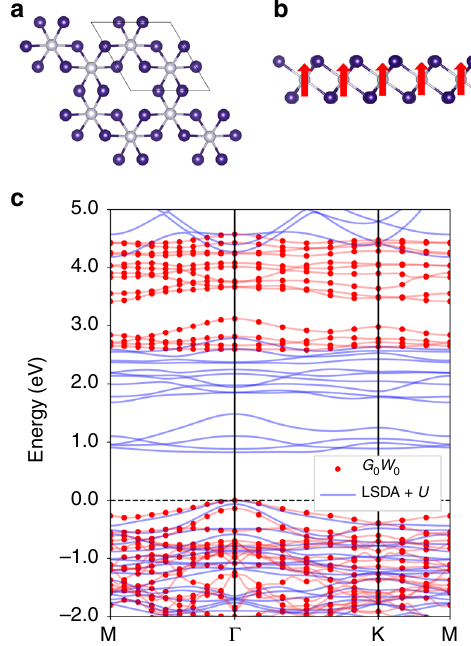
Fig. 1 Crystal structure and electronic structure of ferromagnetic monolayer CrI 3 . a Crystal structure (top view) of monolayer CrI 3 . Chromium atoms are in gray while iodine atoms in purple. b Crystal structure (side view) of ferromagnetic monolayer CrI 3 . Red arrows denote the out-of-plane magnetization, which is pointing along the + z direction. c G 0 W 0 (red dots) and LSDA + U (blue lines) band structures of ferromagnetic monolayer CrI 3 . A rotationally invariant Hubbard potential is employed with U = 1.5